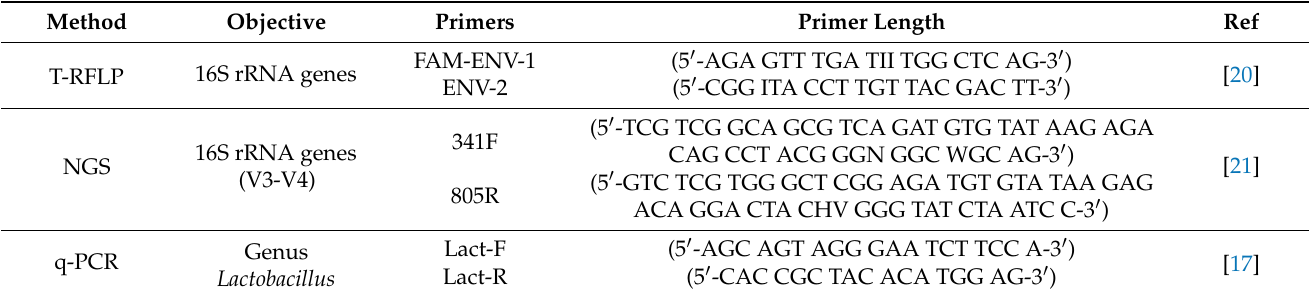
Table 1. Primers used for